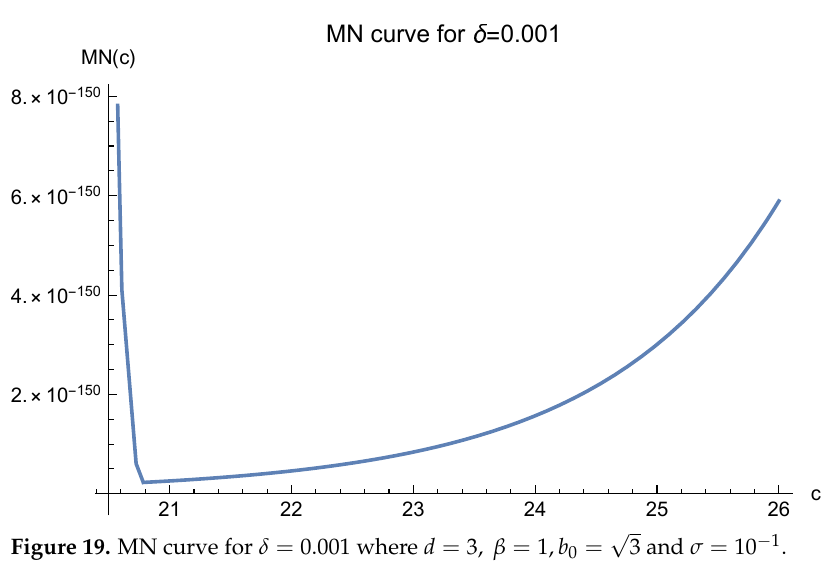
Figure 18. MN curve for δ = 0.01 where d = 3, β = 1, b 0 =